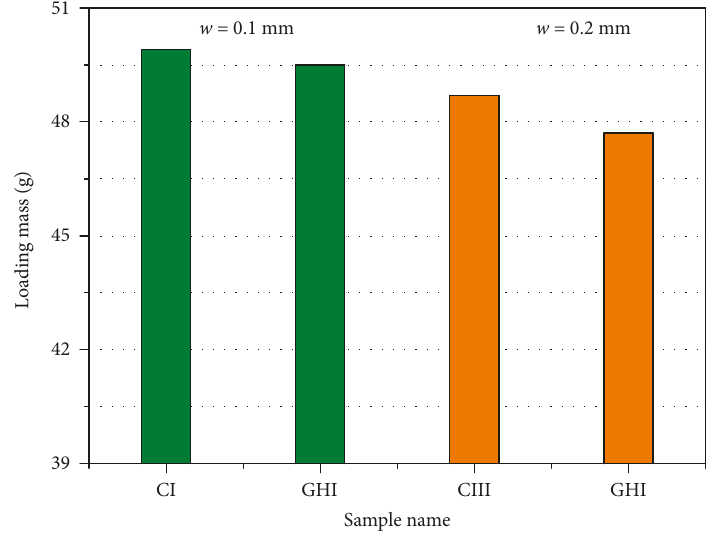
Figure 13: Loading mass at di ff erent